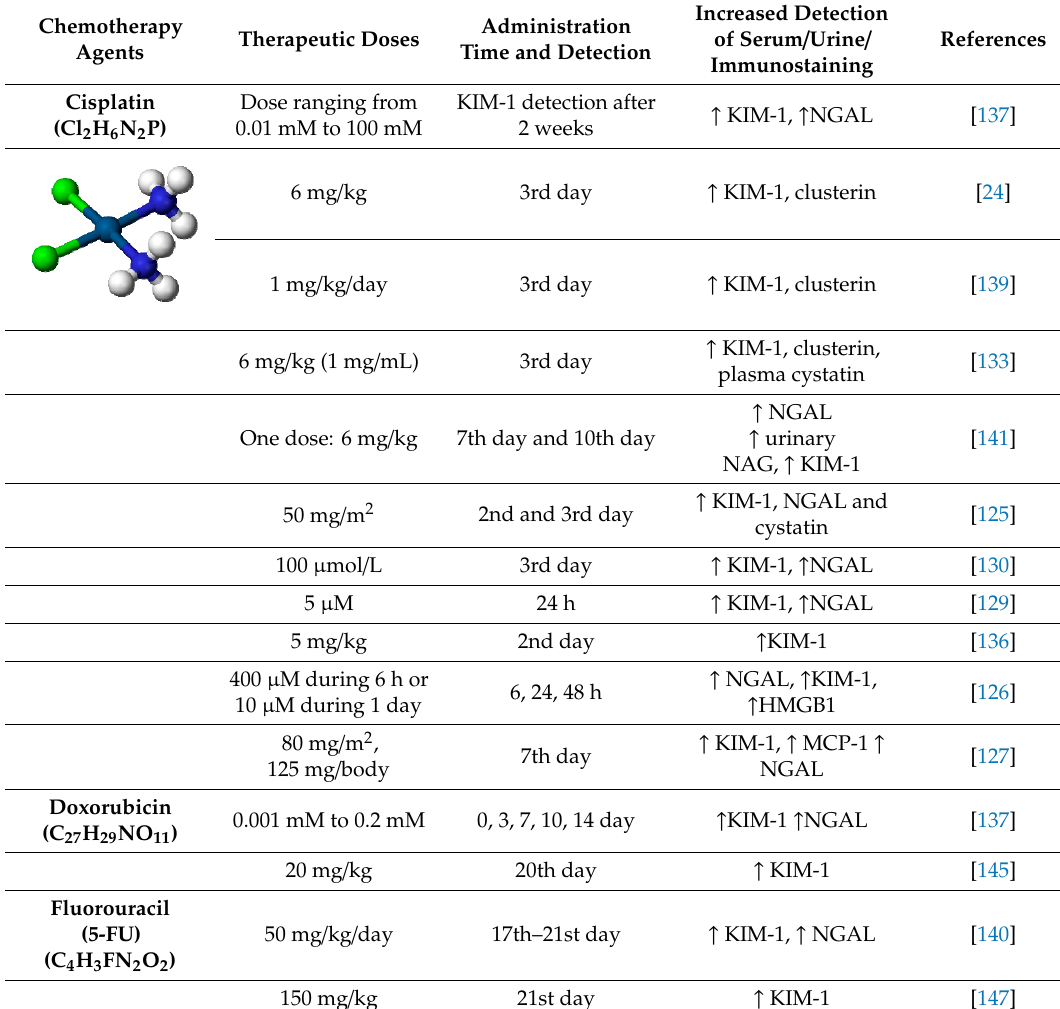
Table 1. Neoplastic drugs and their effect on renal biomarkers